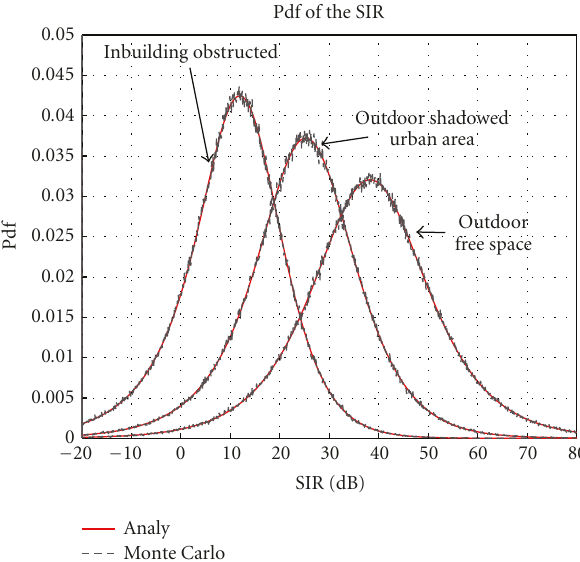
Figure 3: Plots of the pdf of the SIR for di ff erent environments.